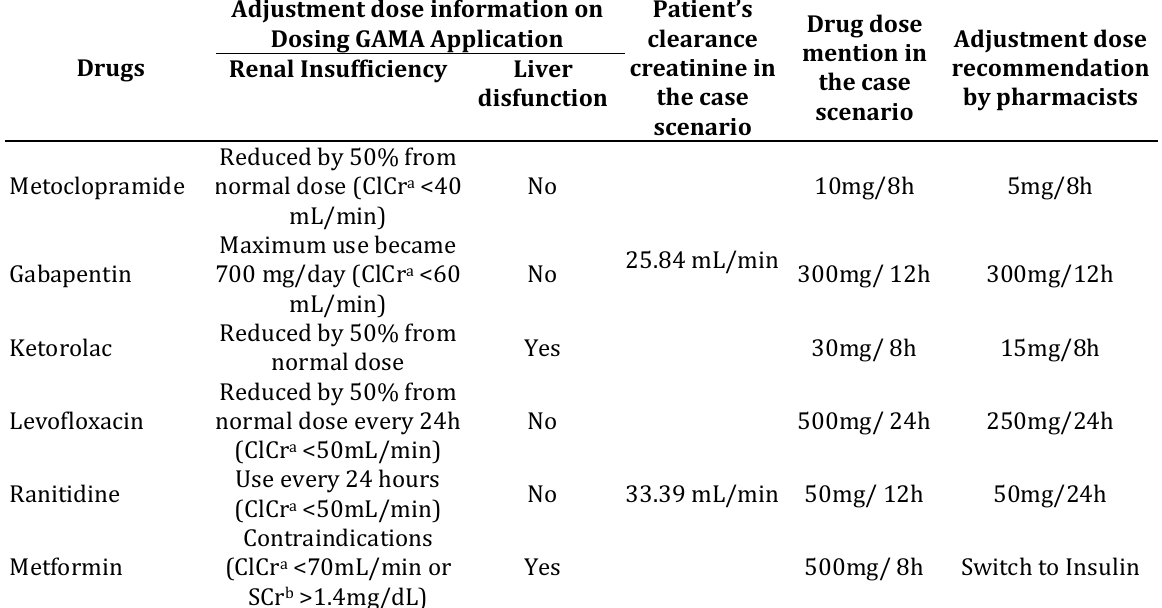
Table III. Type of drug which require adjustment dose on the case scenarios based on the Dosing GAMA Application